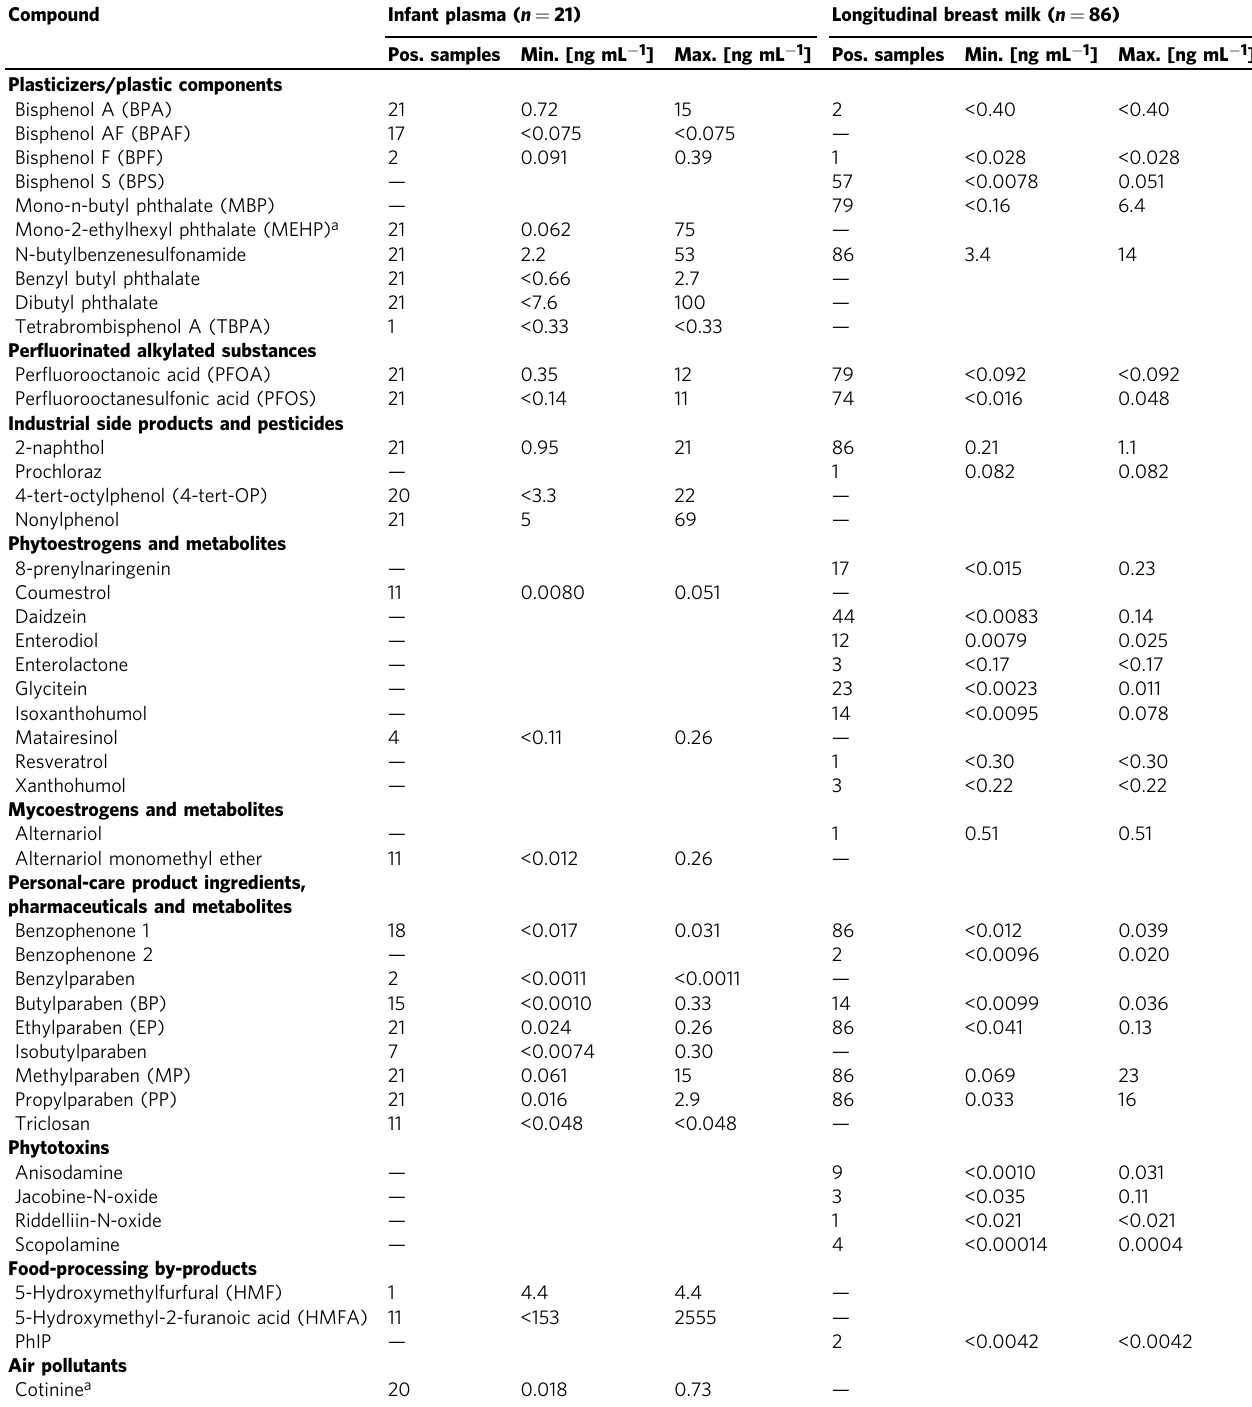
Table 1 Results of two independent proof-of-principle studies. Compound Infant plasma ( n = 21) Longitudinal breast milk ( n =